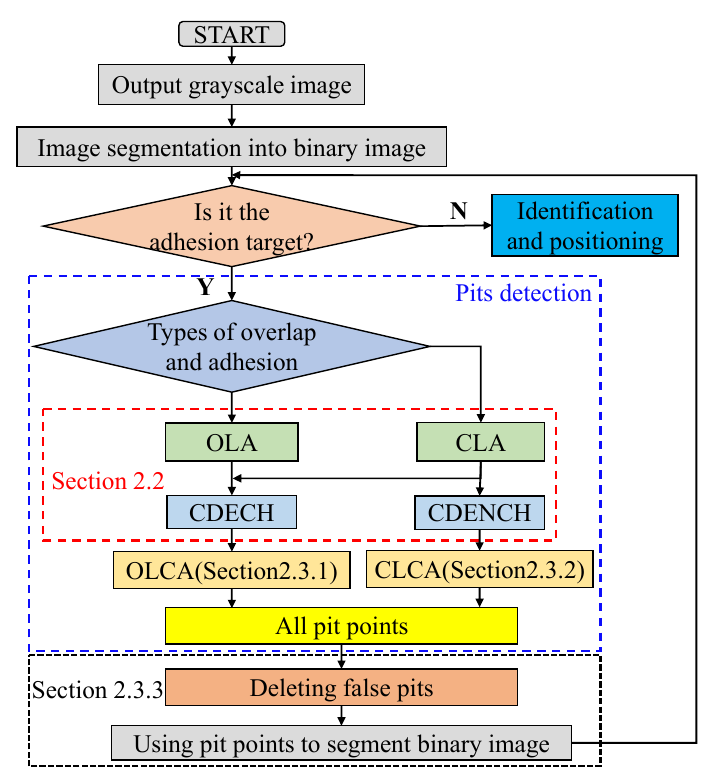
Figure 12. Flow chart of the algorithm in this paper.